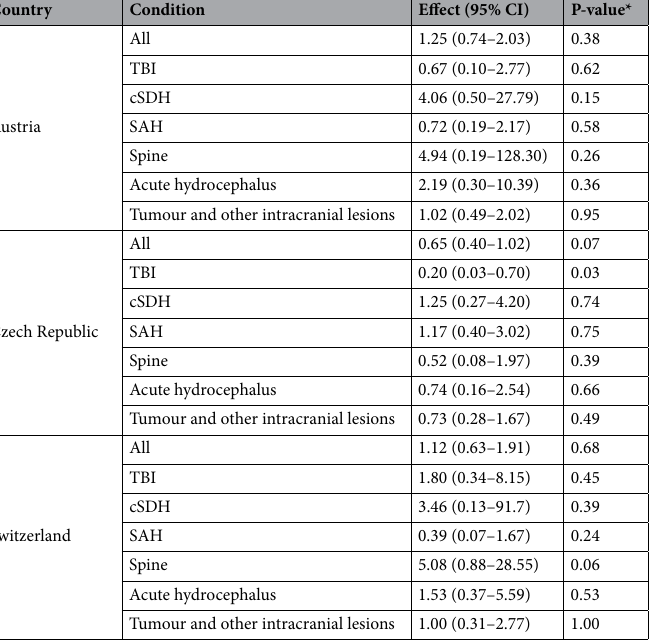
Table 4. Logistical regression of 30-day mortality in non-elective neurosurgical cases in Austria, Czech Republic and Switzerland. Effects estimates reflection 2020 compared to aggregate of reference years (2017–2019). CI confidence interval, TBI Traumatic brain injury, cSDH chronic subdural hematoma, SAH subarachnoid haemorrhage and other vascular pathologies. *All models adjusted for age and